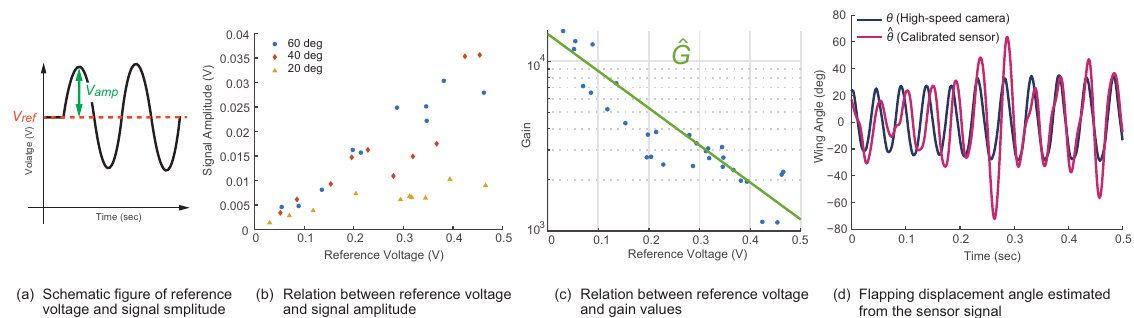
Schematic figure of reference (a) Relation between reference voltage Relation between reference voltage (c) Flapping displacement angle estimated (d)(b) voltage and signal smplitude and signal amplitude and gain values from the sensor signal Figure 10. Model for translating the signal amplitude into insect wing angle. Using the reference voltage and signal amplitude defined in ( a ), their relationships are shown in ( b ), and the exponential trend line is shown in ( c ). Using the linear model, the wing angle trajectory of a dragonfly is compared with the calibrated sensor signal ( d